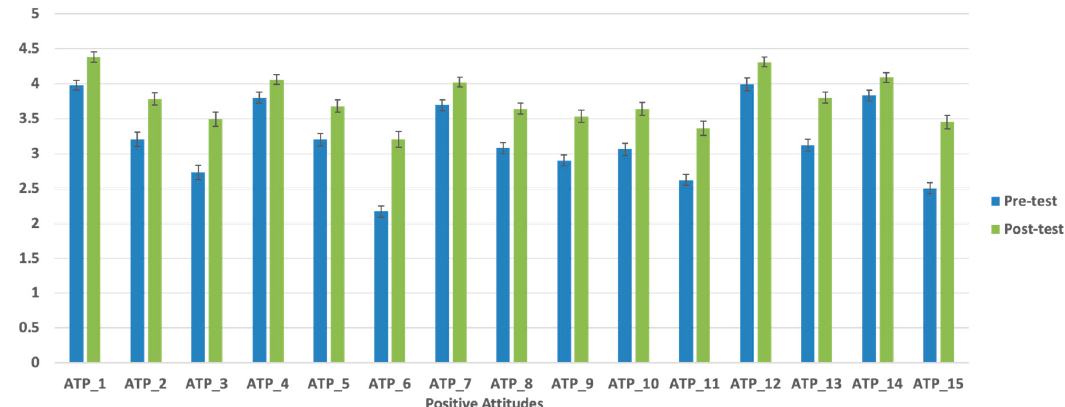
Figure 4. Mean values of the scores given for the pre- and post-test questionnaire by the 143 participants for the positive attitudes (ATP) of the PSTs toward mathematics learning through the flipped-OCN method.